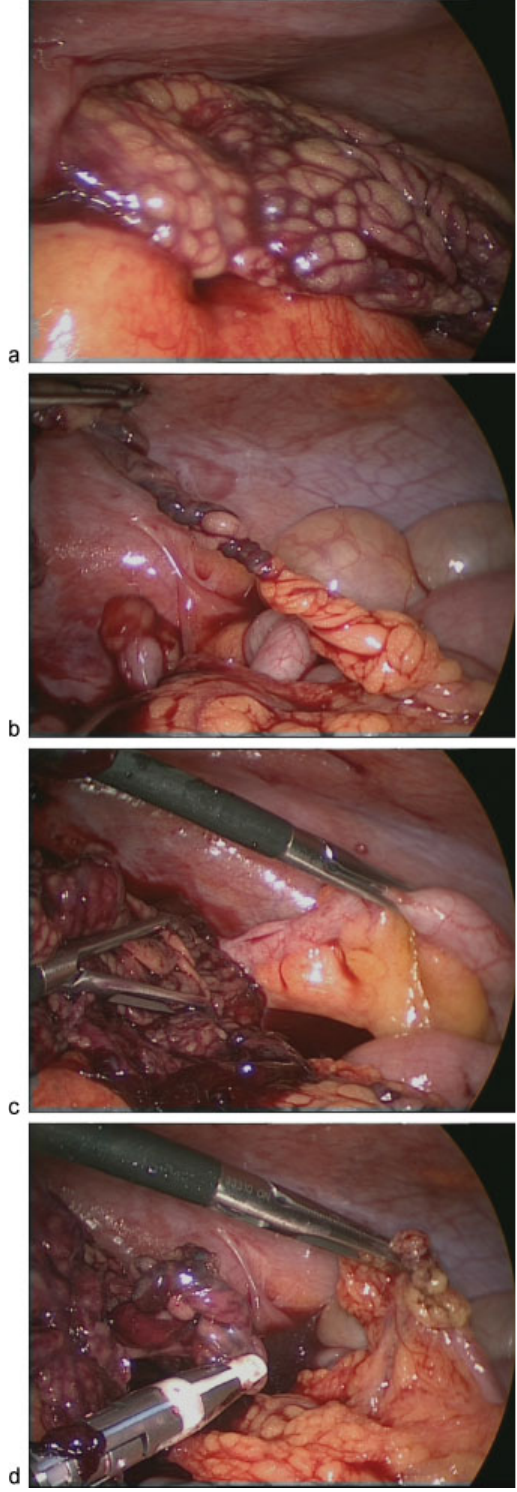
Fig. 1 Laparoscopic fi ndings: (a) necrotic omentum fi xed to internal inguinal ring; (b) omentum twisted around its axis; (c) normal appendix; and (d) omentum removal with LigaSure.